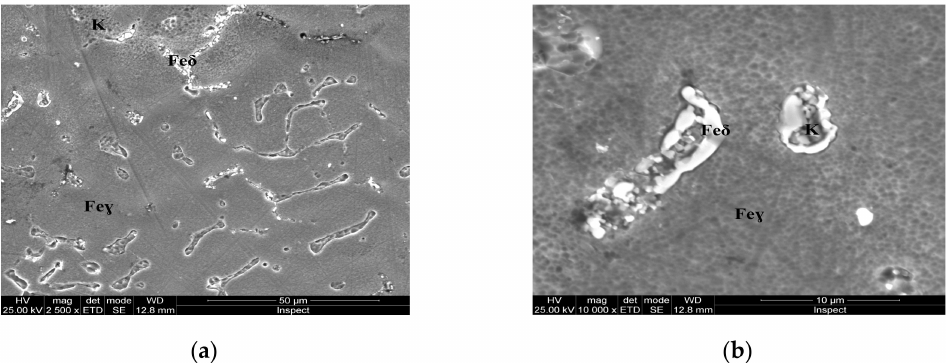
Figure 6. Microstructure of the AISI 316 modified stainless steel sample, heat-treated (Sample B): ( a ) Fe γ base matrix, Fe δ phase, and carbides (K), × 2500; ( b ) detail of the Fe δ phase surrounded by carbides, × 10,000.